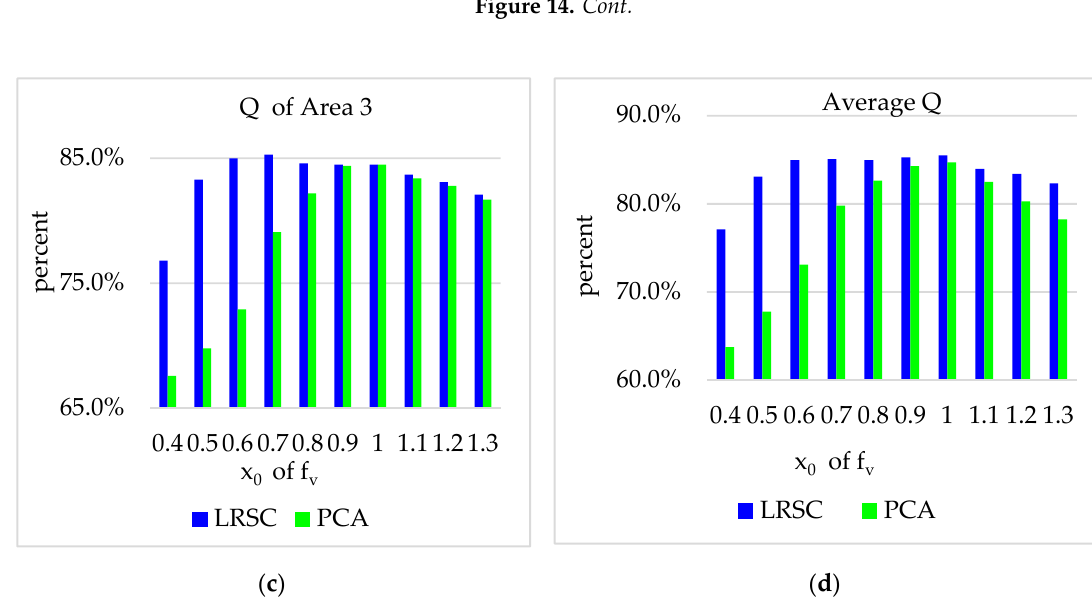
Figure 14. Cont. Remote Sens. 2020 , 12 , x FOR PEER REVIEW